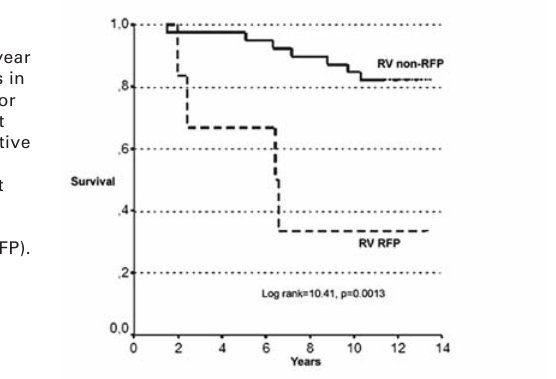
Figure 2 Kaplan-Meier 15-year survival estimates in thalassaemia major patients with right ventricular restrictive filling pattern (RV-RFP) and right ventricular non- restrictive filling pattern (RV-non